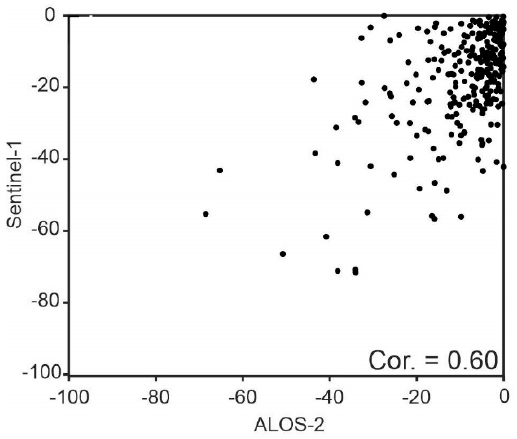
Figure 8. Scatter plot of PALSAR–ALOS-2 versus Sentinel-1 velocities.